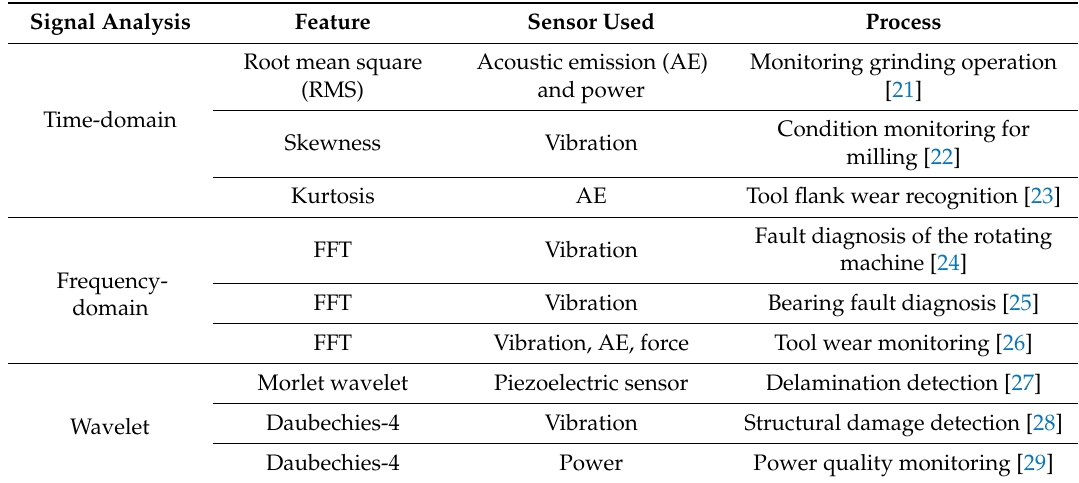
Table 1. Previous research e ff orts in anomaly detection using three signal-processing techniques.